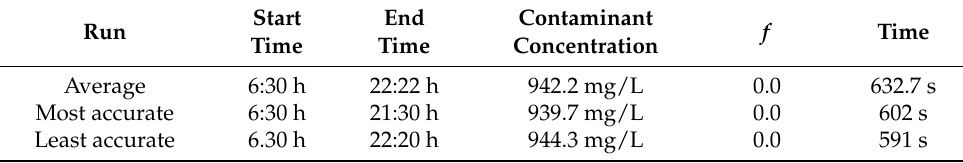
Table 11. Framework 2 results for the Richmond network for the source node